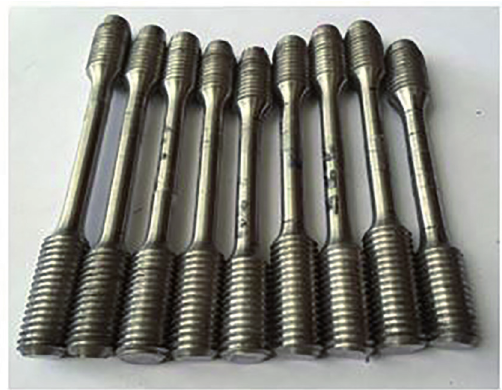
Figure 4: Tensile test specimens